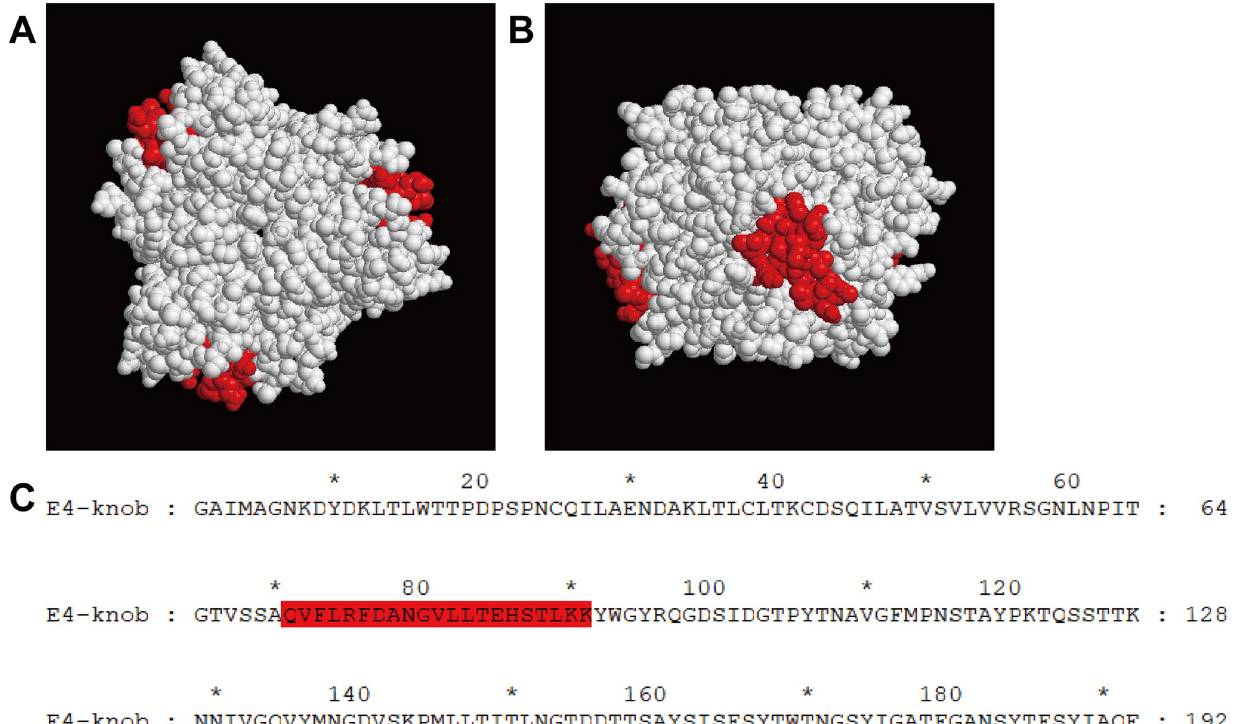
Fig 8. 3D structure of the HAdV-E4 knob protein and the predicted linear epitope. The predicted linear epitope region on the HAdV-E4 knob protein is located in the neck region on the side of the 3D model. The predicted linear epitope region is highlighted in red on the model in both top (A) and side (B) views. The amino acid sequence of the predicted linear epitope is highlighted in red in the sequence of HAdV-E4 knob protein.